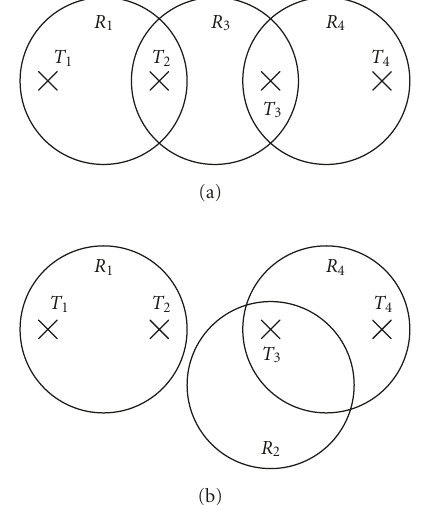
Figure 5: The reduced RFID network after performing (a) RRE and (b) LEO .